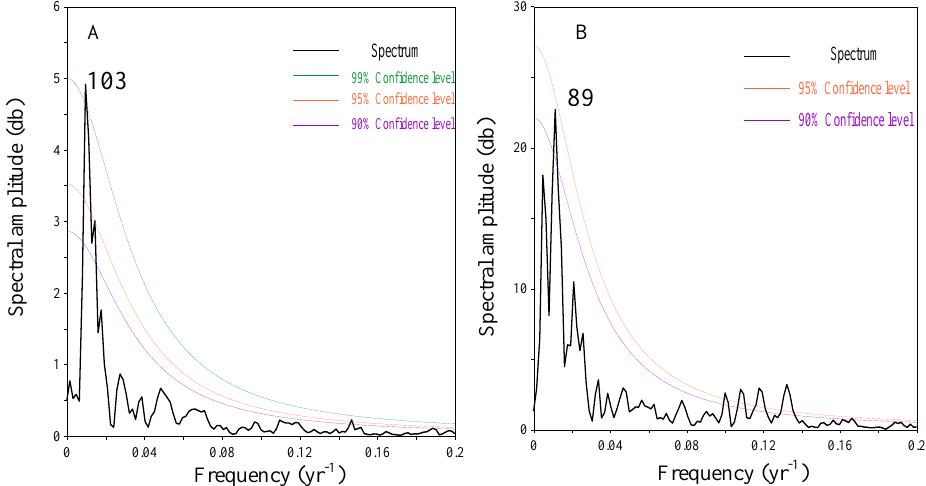
Fig. 7. Spectral analyses of the δ 18 O (A) and δ 13 C (B) records during LIA. Spectral peaks are labeled with their period (in yr). The spectra were calculated with software REDFIT (Schulz and Mudelsee,